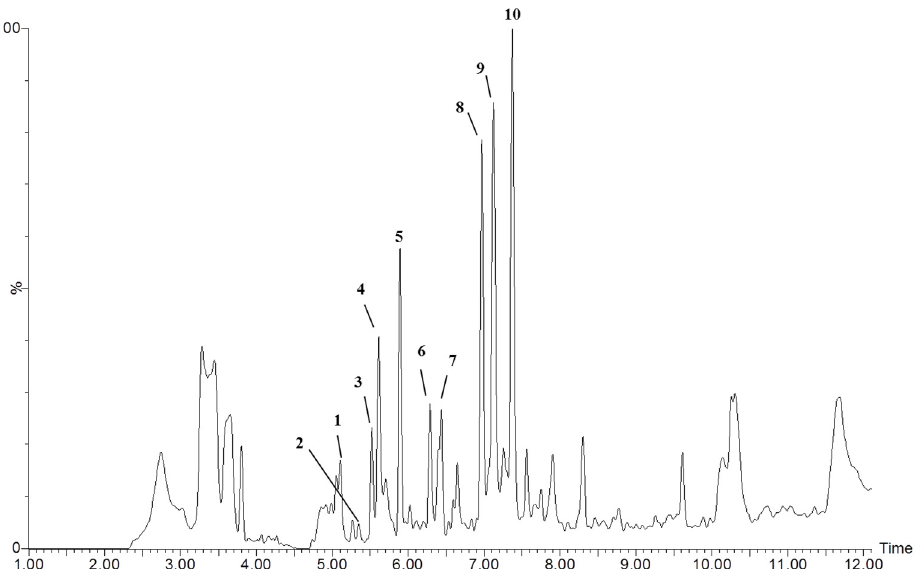
Figure 1. Representative UHPLC-ESI-QTOF-MS chromatogram of V. polyanthes leaf rinse extract (Vp-LRE) in the negative mode.